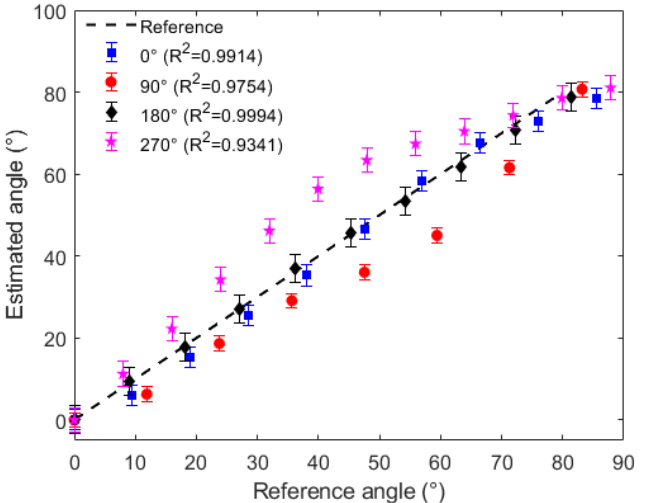
Figure 8. Angular position estimation at x – y plane for the POF sensor at different lateral section